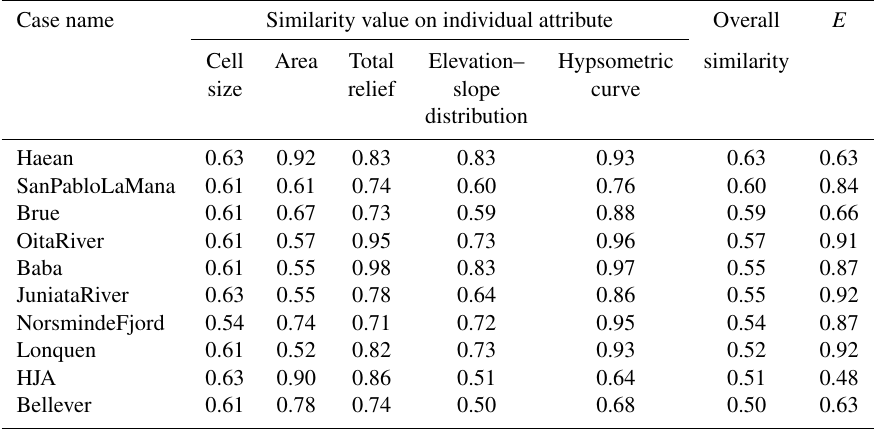
Table 6. Top 10 similarity values between the Kasilian evaluation case and existing cases as reasoned by the proposed method. Case